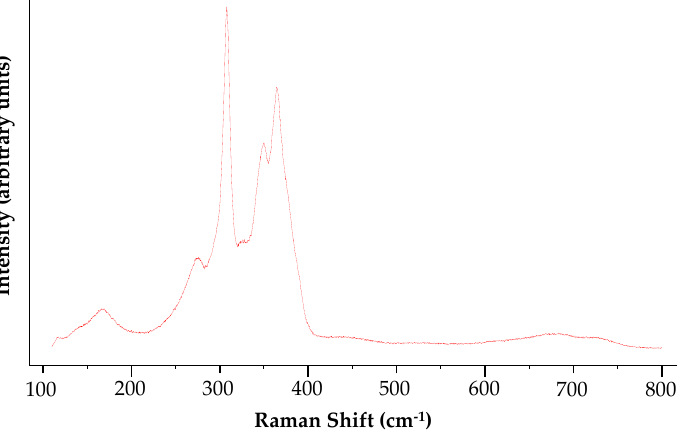
Figure 2. Representative Raman spectrum of a crystalline grain of richardsite in the region 110–800 cm − 1 using incident laser excitation with a 632.8-nm wavelength.